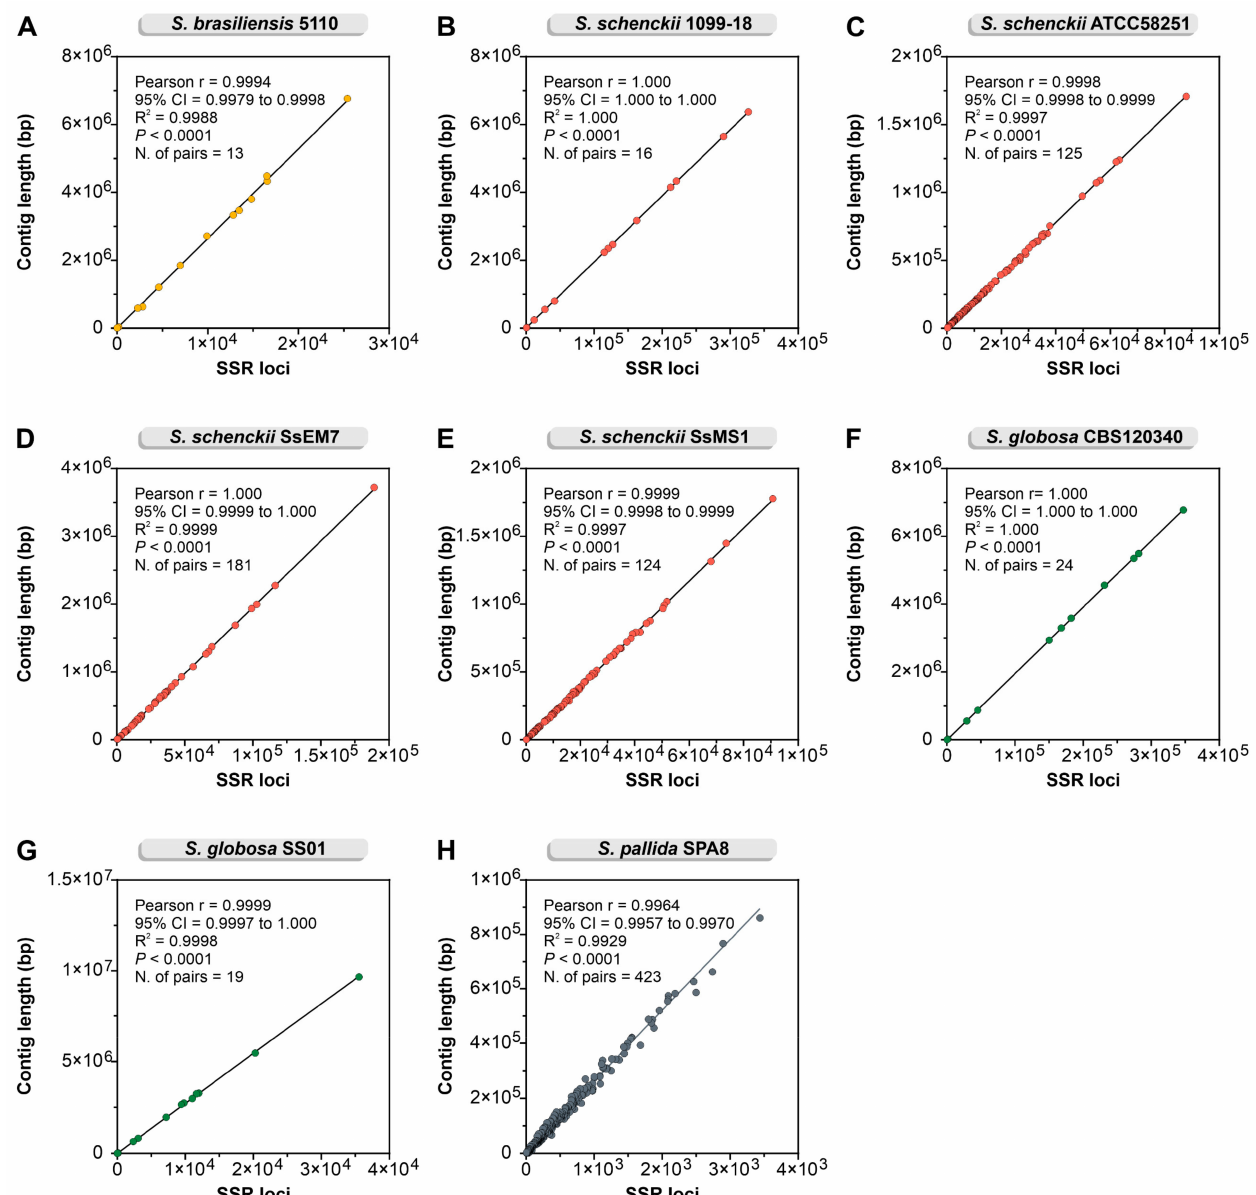
Figure 4. Pearson correlation analysis between SSR loci count (minimum of 3 repeats and motifs of 2–10 bp) and each contig length shows a positive correlation (R = 0.99–1.00; p < 0.0001) for all Sporothrix genomes analyzed: ( A ) S. brasiliensis 5110; ( B ) S. schenckii 1099-18; ( C ) S. schenckii ATCC58251; ( D ) S. schenckii SsEM7; ( E ) S. schenckii SsMS1; ( F ) S. globosa CBS 120340; ( G ) S. globosa SS01; ( H ) S. pallida